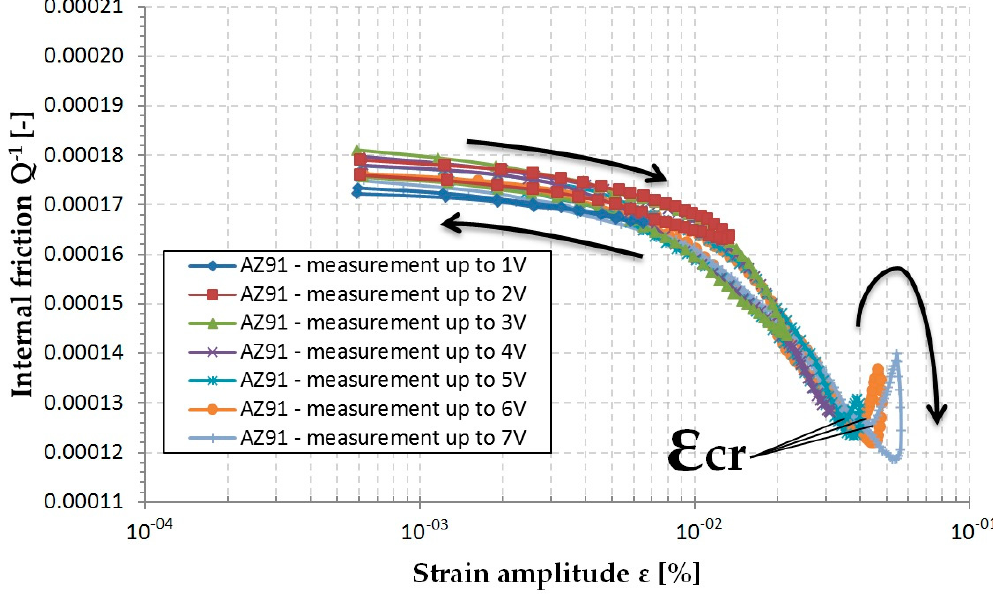
Figure 11. Amplitude dependencies of IF measured for the AZ91 alloy and increasing maximum strain amplitudes.